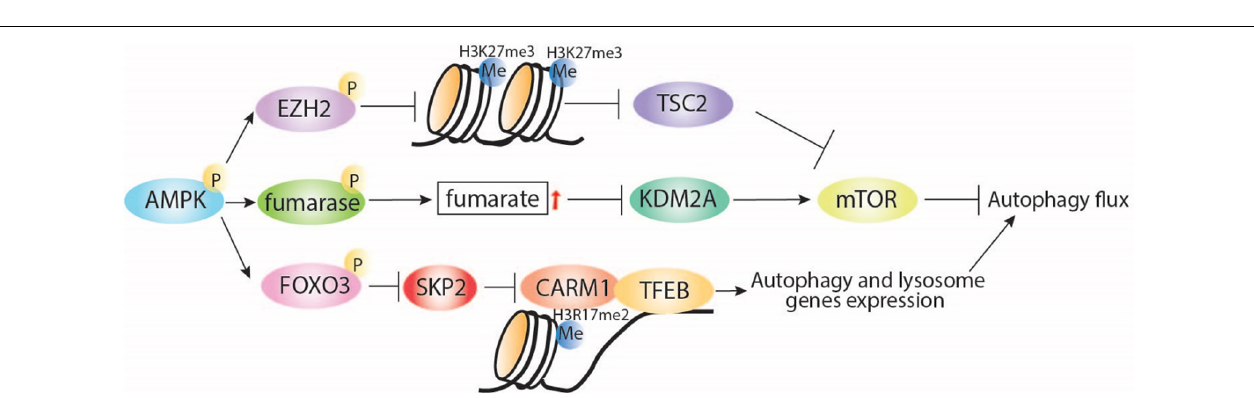
FIGURE 1 | AMPK-SIRT1-autophagy signaling pathway. Adenosine monophosphate phosphorylates GAPDH which in turn translocates to the nuclei, activates Sirt1 through direct interaction allowing LC3 and histone deacetylation, Brd4 release, recruitment of the methyltransferase G9a and induction of autophagy. Ac, acetylation; P, phosphorylation; Me, methylation.